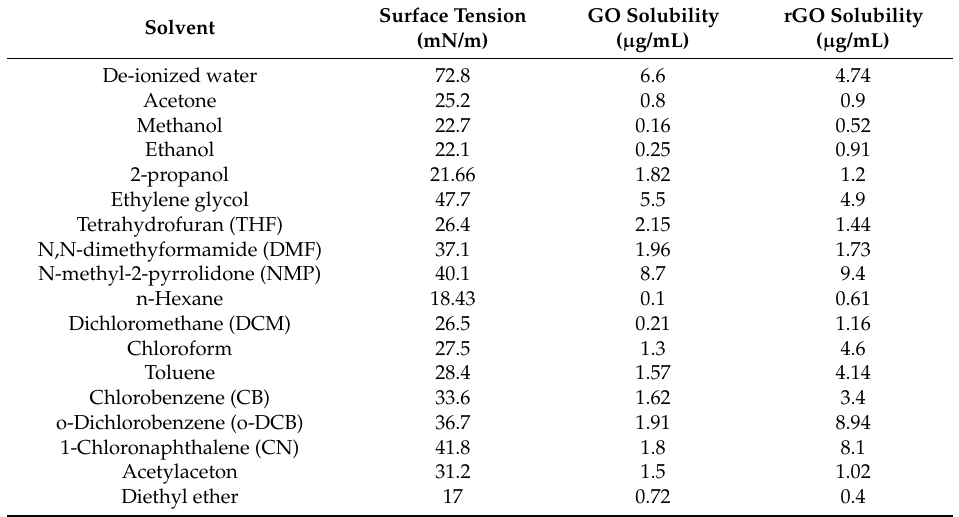
Table 1. Surface tensions and solubility parameters of solvents for GO, reduced graphene oxide (rGO). Adapted from Konios et al.